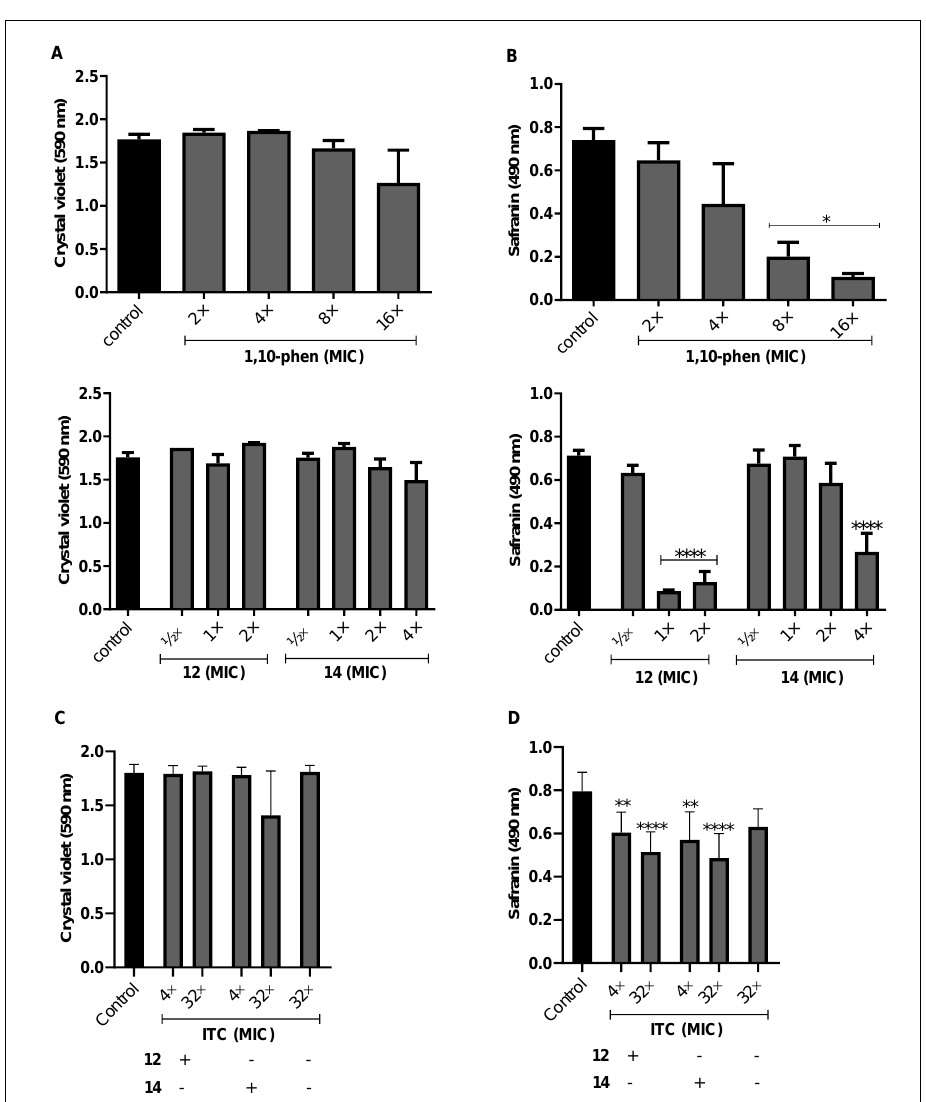
Figure 2. Effect of phen and its silver complexes on F. pedrosoi biomass and extracellular matrix during biofilm formation. ( A , B ) Conidia were added to 96-well microplates containing RPMI medium and non-cytotoxic concentrations of each compound. ( C , D ) Conidia were treated with a combination of non-inhibitory concentrations of itraconazole and the complexes 12 ( 1 / 2 MIC) and 14 (2 × MIC). The systems were incubated for 72 h at 37 ◦ C and then biofilm biomass ( A , C ) and extracellular matrix ( B , D ) were quantified by incorporation of crystal violet and safranin, respectively. Systems containing only non-treated conidia were also prepared (control). * p < 0.05, ** p < 0.01, **** p <